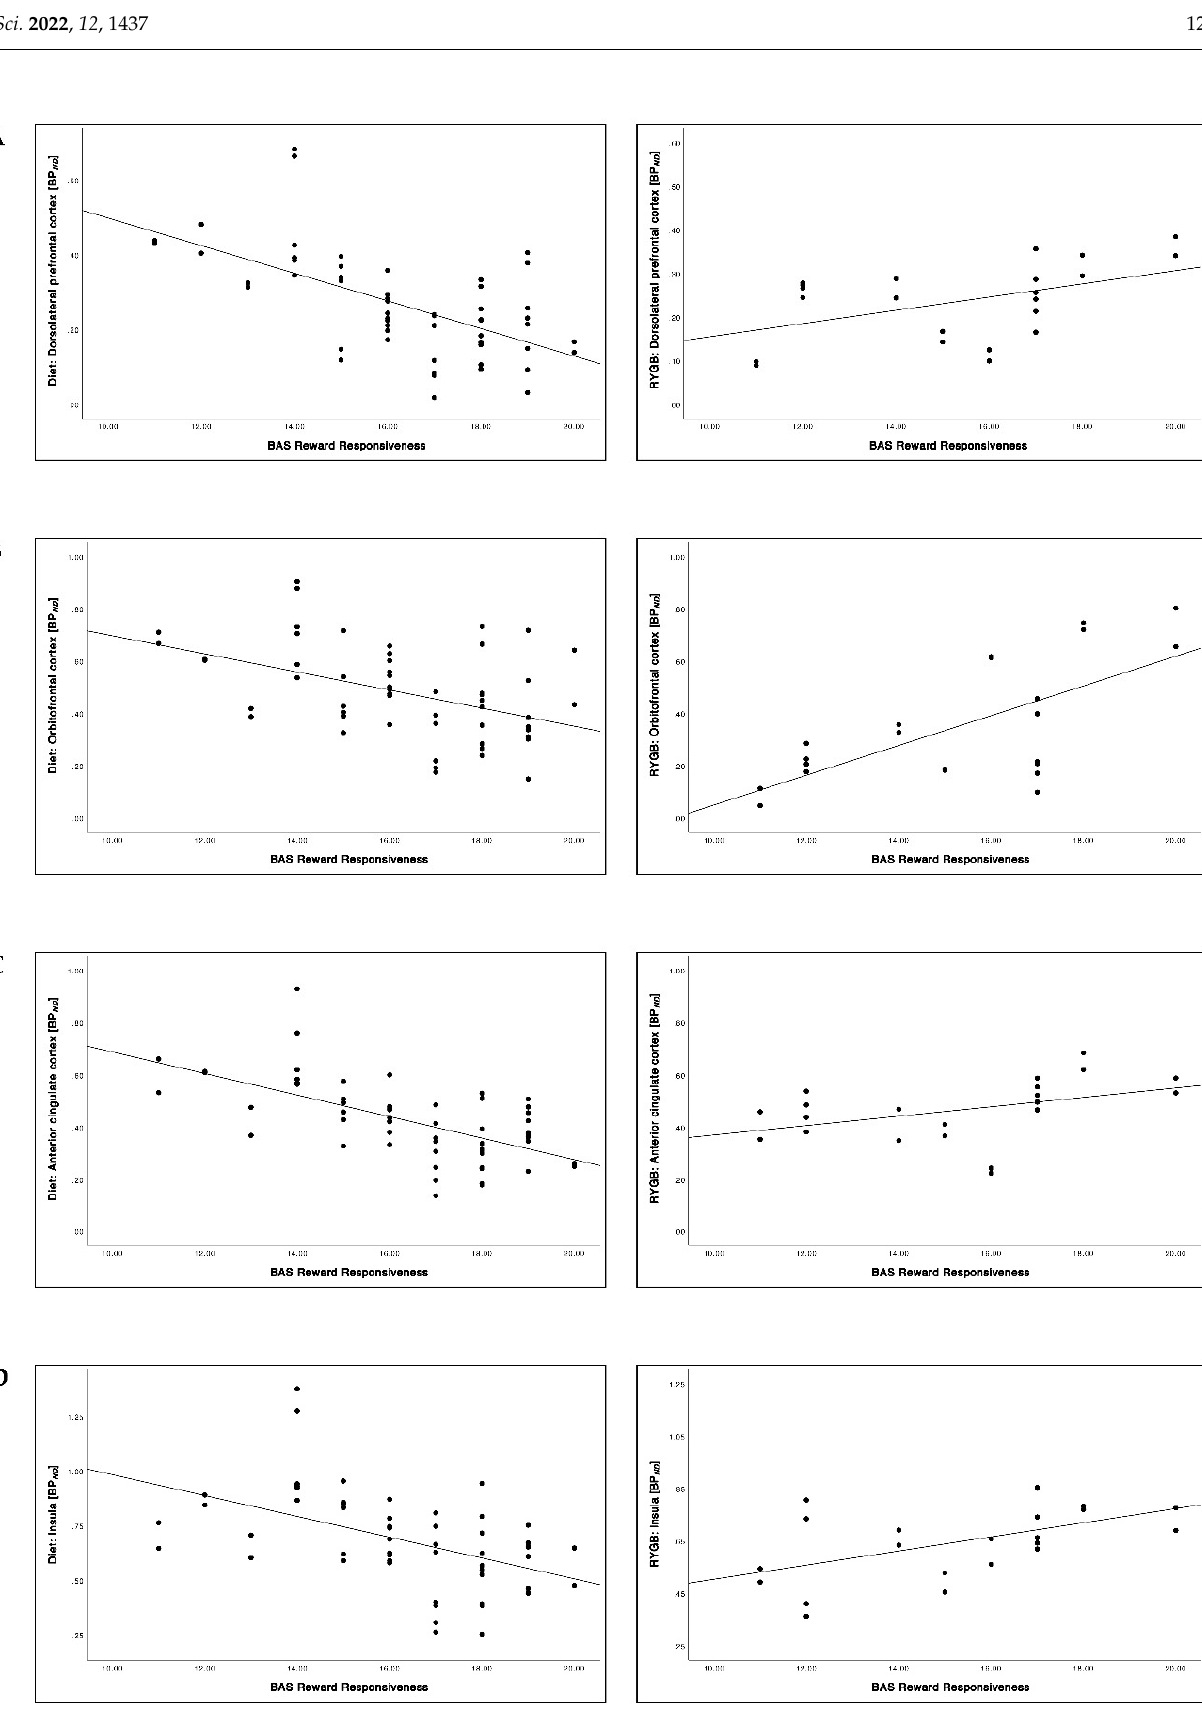
Figure 8. Relationship between BAS reward responsiveness and 5-HTT BP ND in the dorsolateral prefrontal cortex (dlPFC) ( A ), the orbitofrontal cortex (OFC) ( B ), the anterior cingulate cortex (ACC) ( C ) and the insula ( D ) before intervention (at baseline).